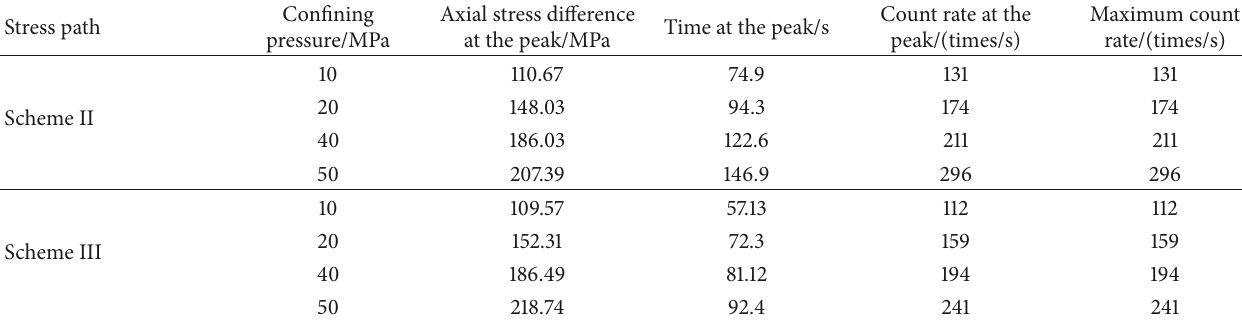
Table 2: Count rate of sandstone sample under various confining pressures in Schemes II and